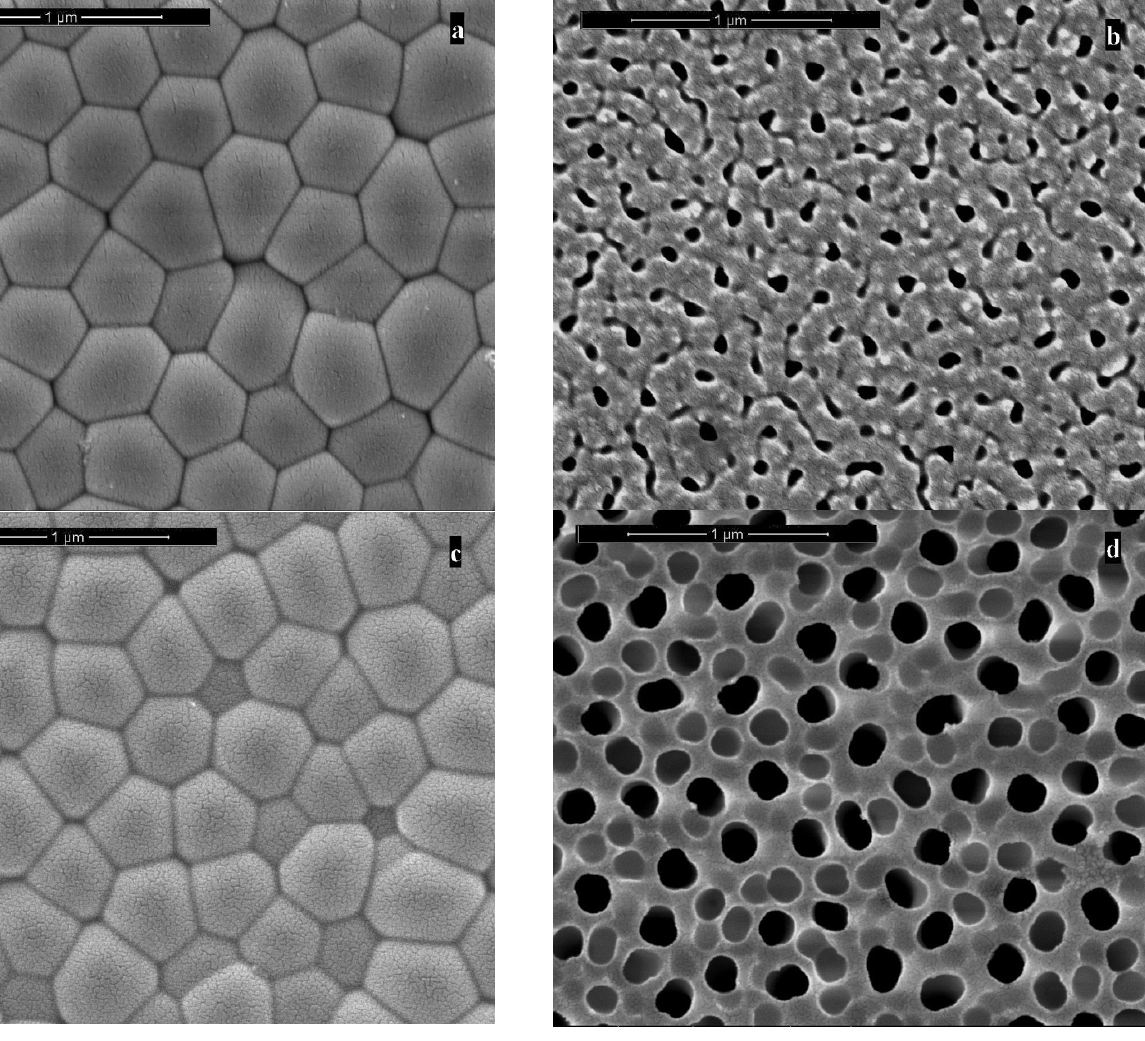
Figure 3. Top views of PAA formed in 0.4 M H 3 PO 4 and 0.04 M Al(OH) 3 at 160 V and 0 °C: ( a ) and ( b ) inner, and outer surface at 20 C cm − 2 , respectively; ( c , d ) inner, and outer surface at 160 C cm − 2 , respectively.